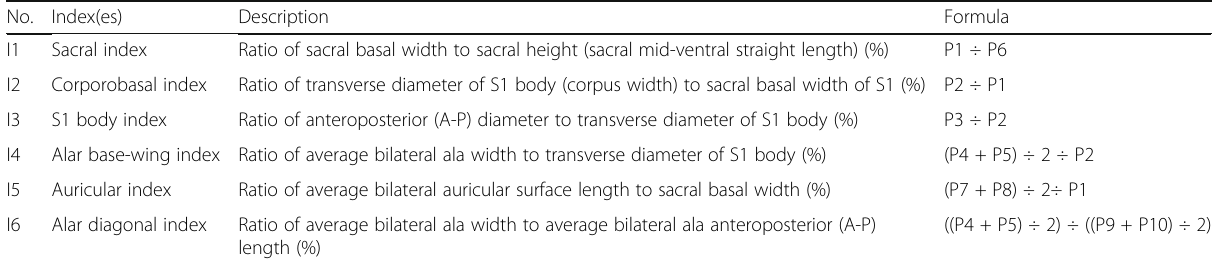
Table 3 Definition and description of sacrum indices adopted from Kanika et al. (2011) and Shreekrishna et al. (2013) No. Index(es)